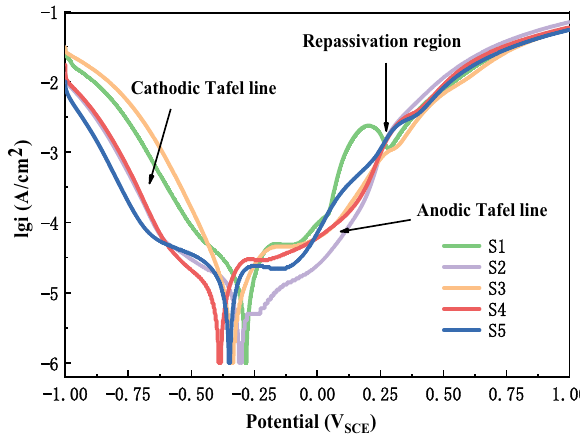
Figure 9: Polarization curves of the S1 – S5 samples in 3.5 wt% NaCl solution.